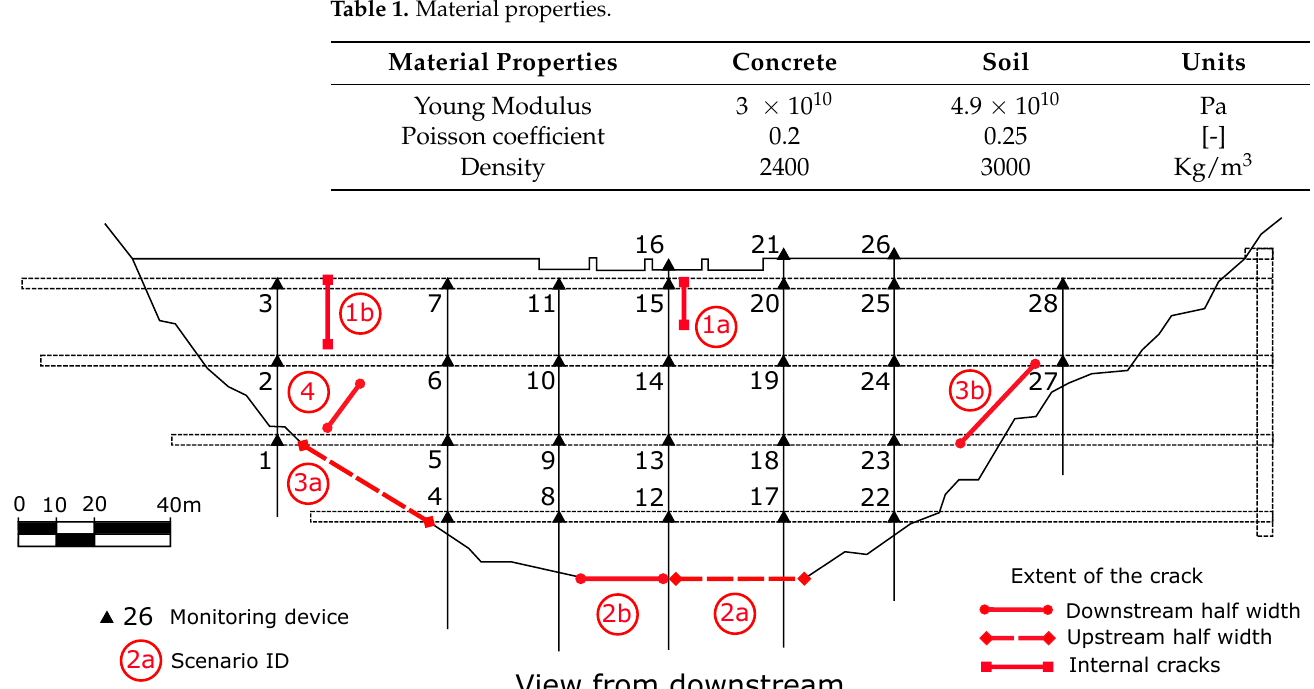
Figure 1. Location of pendulums and cracks considered for each scenario. View from